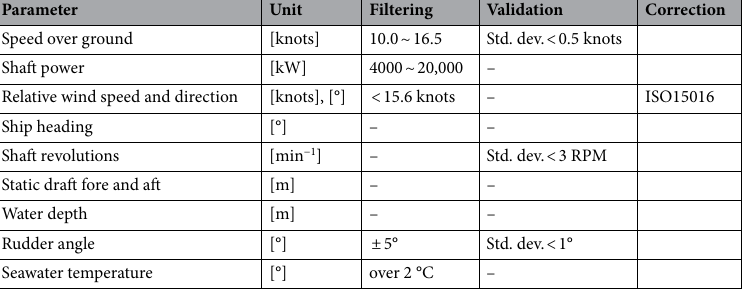
Table 3. Validation and filtering criteria for environmental parameters.